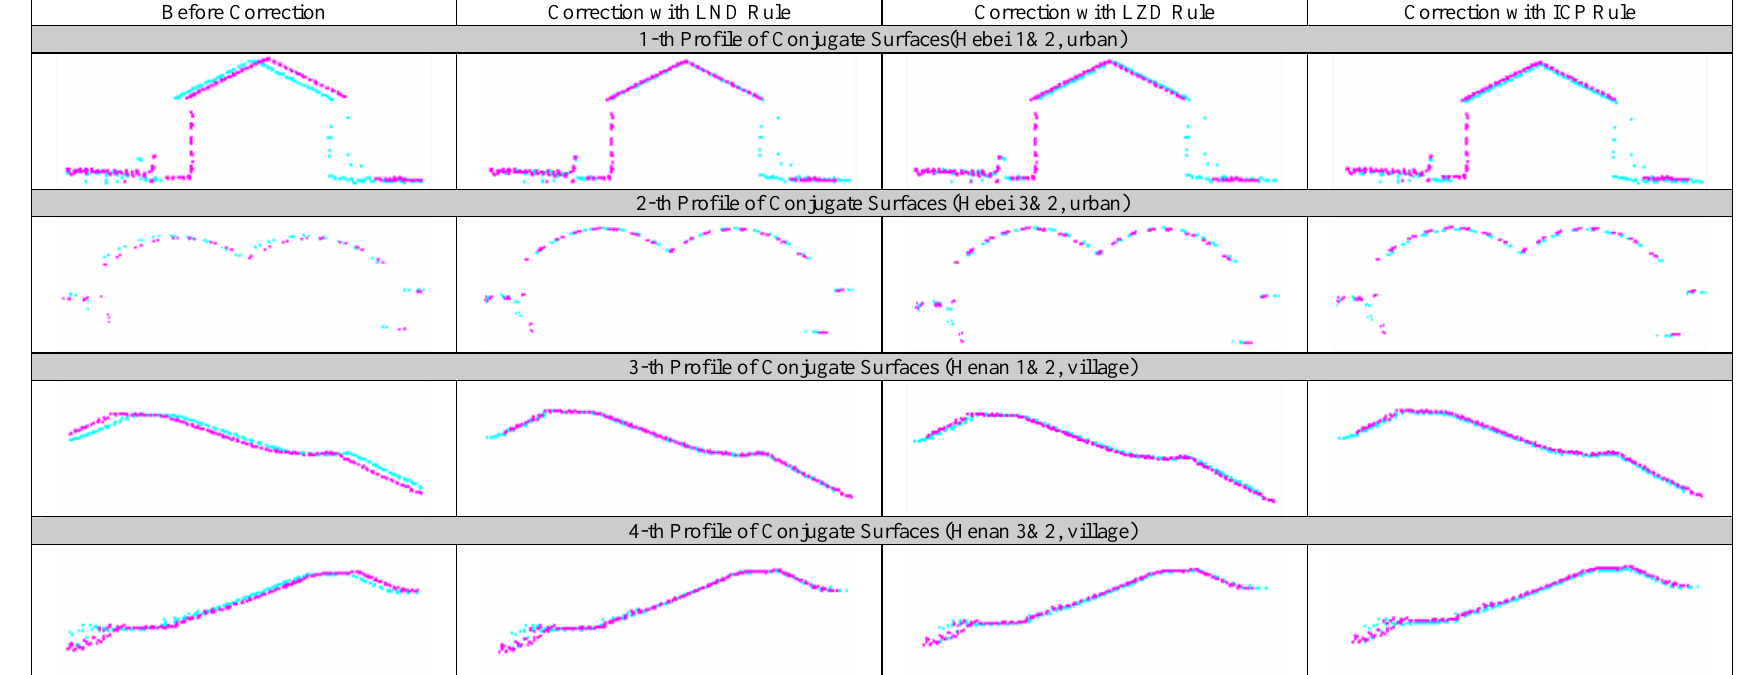
Figure 5. Profiles in overlapping strips (showing the degree of compatibility between the point clouds before and after the surface matching with three rules of conjugate points, and the LND rule has best result.) Before Correction Correction with LND Rule Correction with LZD